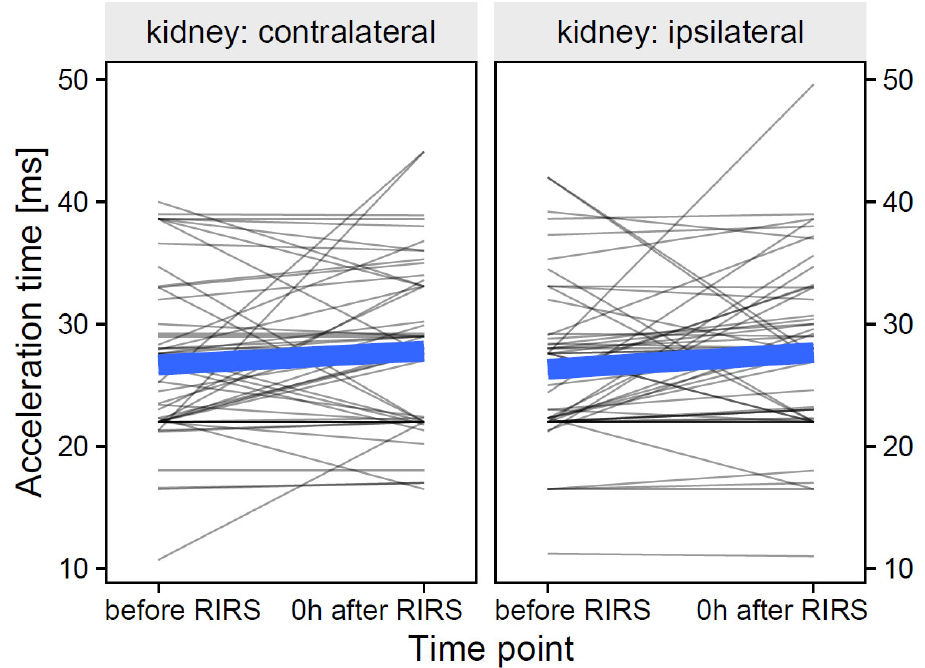
Figure 9. The effect of kidney side on acceleration time over time (the thin, semi-transparent black lines in the background are the individual-level data. The bold blue lines in the foreground are the group averages). The figure shows that the effects of the kidney side on the focal variable of the acceleration time did not differ over time. The inclusion of the effects of mean stone volume, energy used, pre-stenting, and kidney side at separate time points is presented in Sections 3.1.3.1–3.1.3.3.